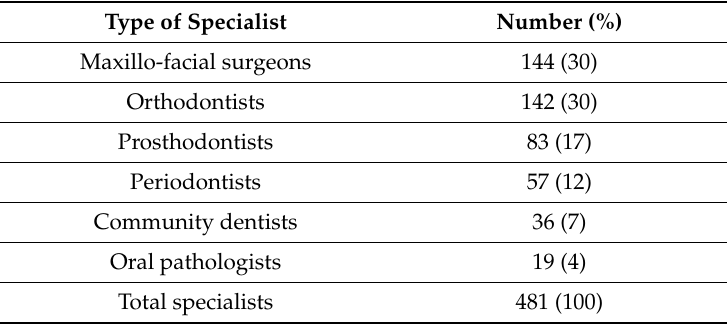
Table 1. Number of dental specialists by area of specialization currently registered in SA ( N =